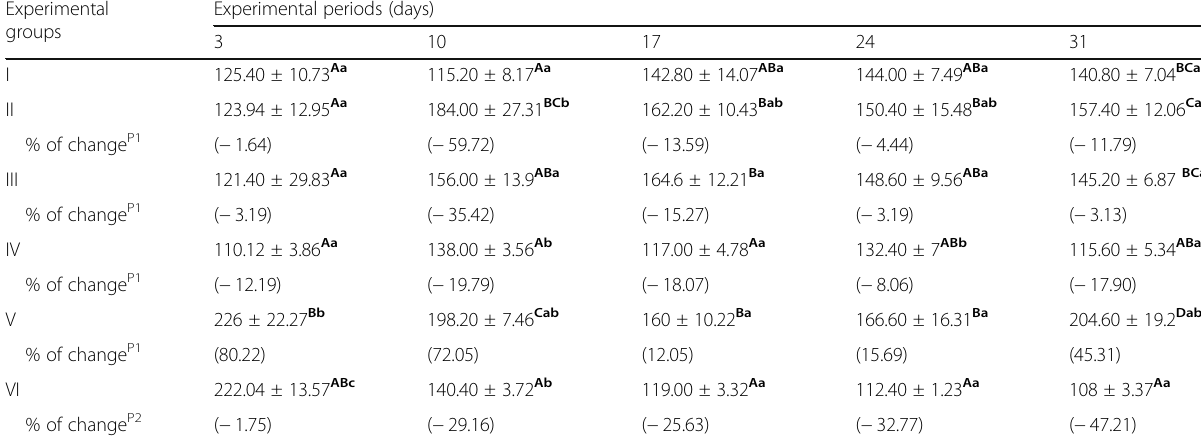
Table 9 Plasma levels of IFN- γ (pg/ml) in the experimental groups at the experimental periods Experimental